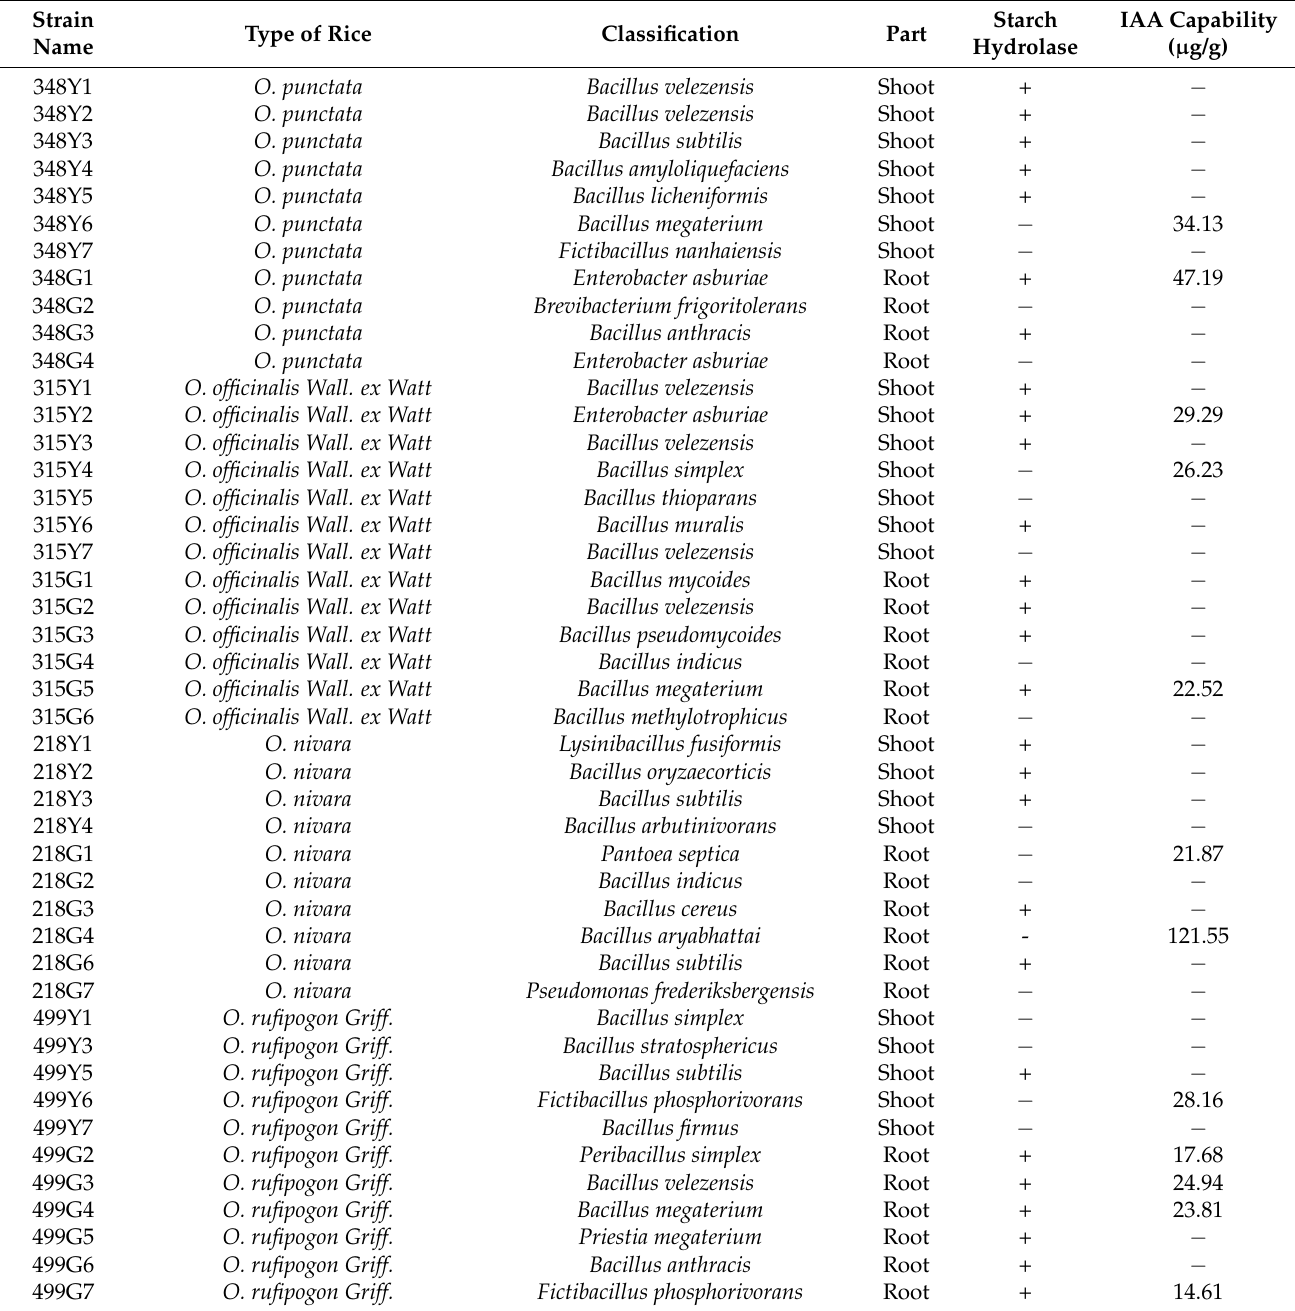
Table 1. Bacterial identification results screened from the rhizosphere and phyllosphere of four wild rice